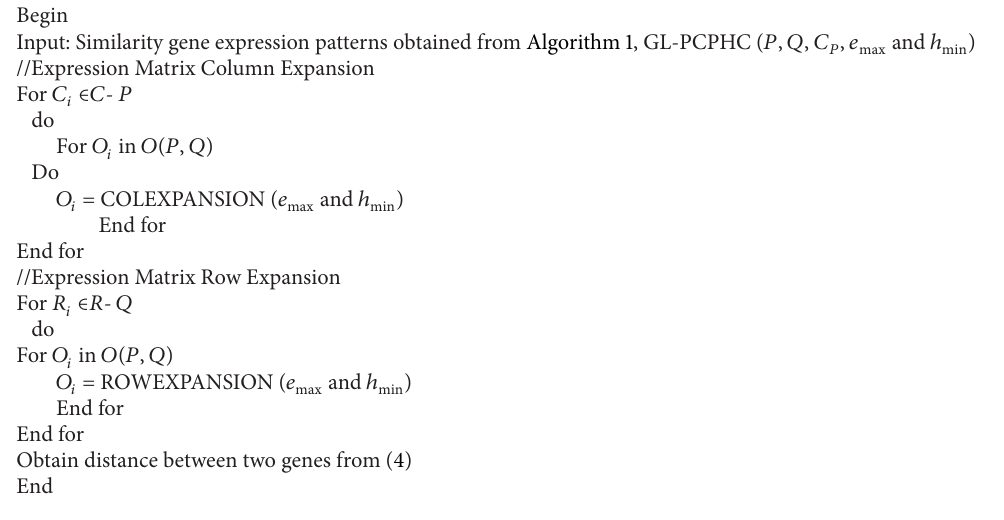
Algorithm 2: Seed Augment